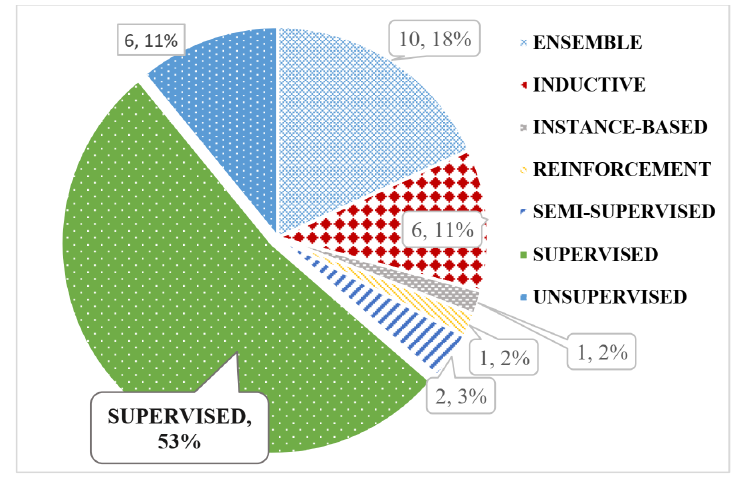
Figure 15. Popularity of machine learning approach types.